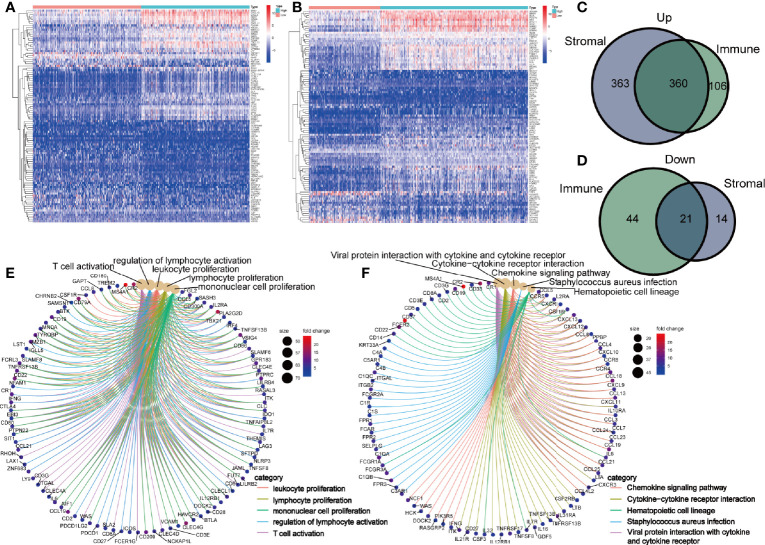
Identification of differently expressed genes (DEGs) shared by immune and stromal score. Heatmap of the top 50 DEGs in immune (A) and stromal components (B). Venn diagram showing the shared upregulated genes (C) and downregulated genes (D) by immune and stromal components. GO (E) and KEGG enrichment analysis (F) for 381 DEGs, terms with p- and q-value < 0.05 were believed to be enriched significantly.